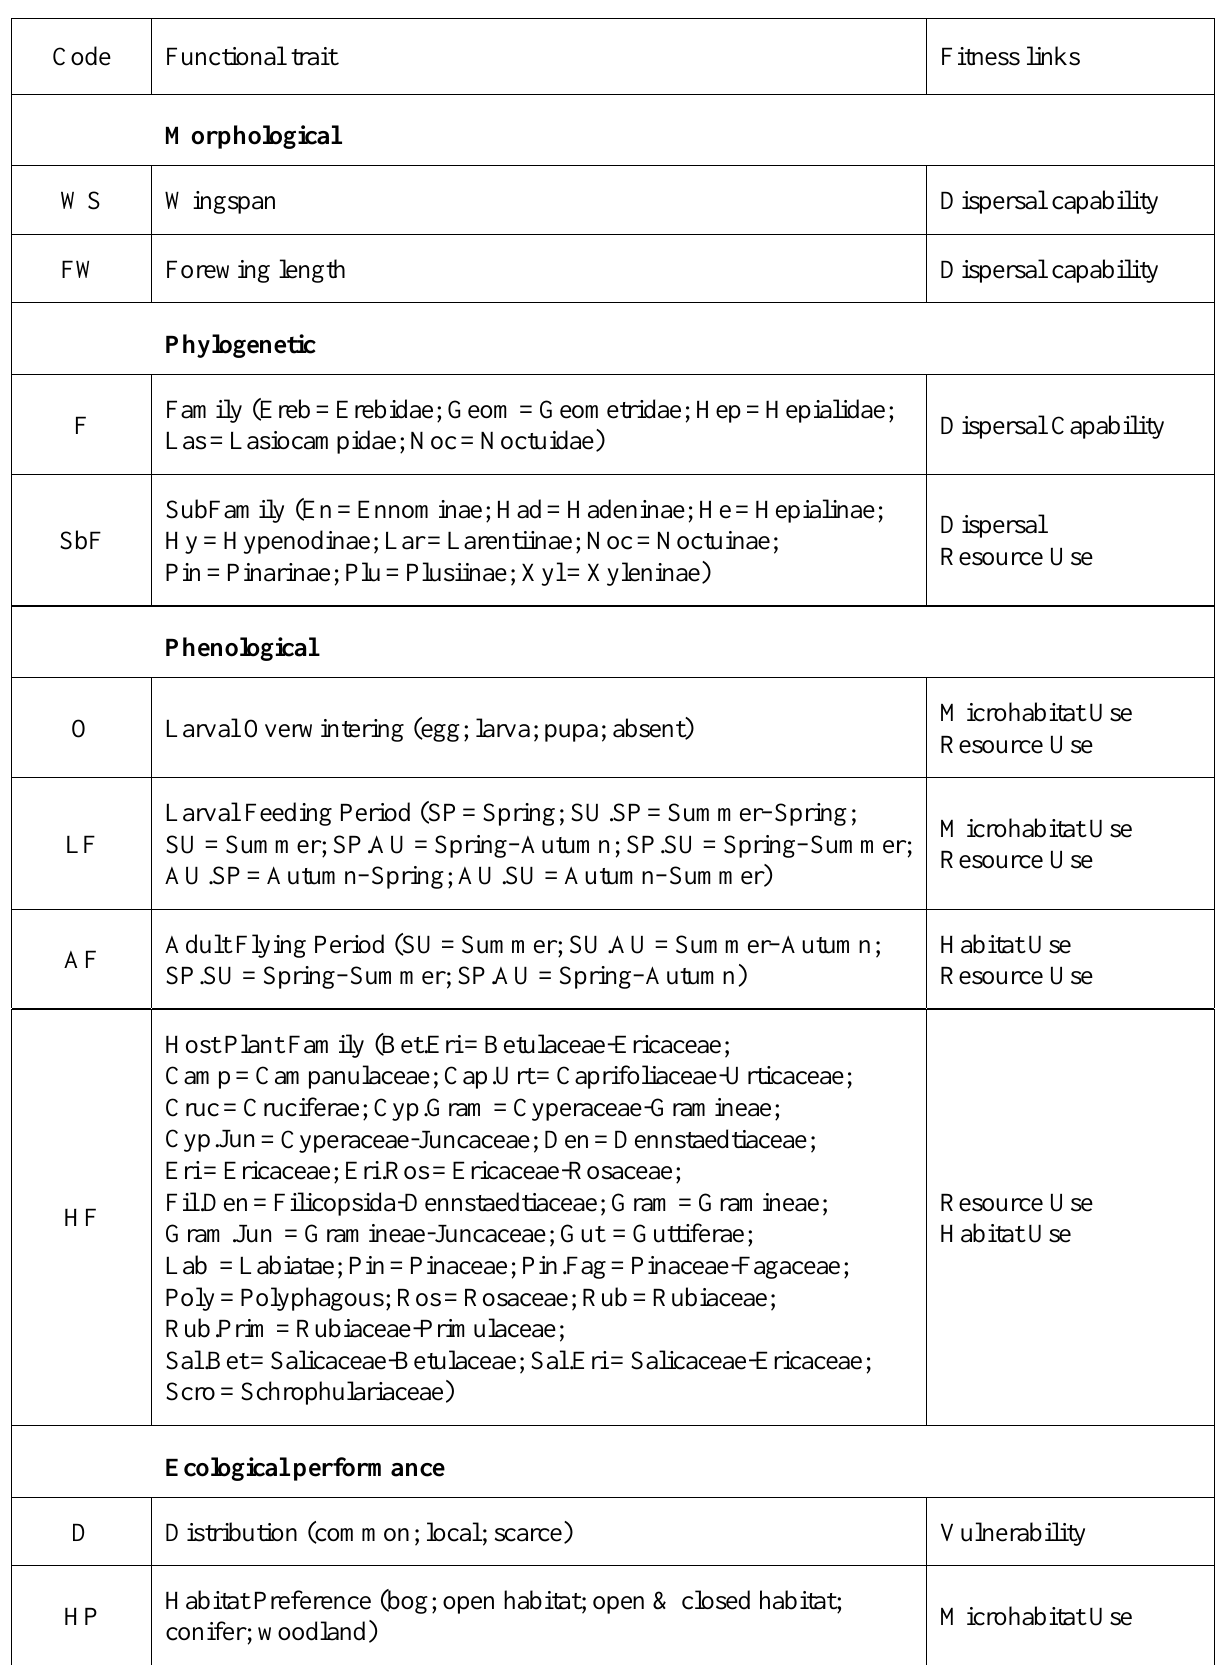
Table 2. Functional traits of Scottish moths used in the calculation of community weighted